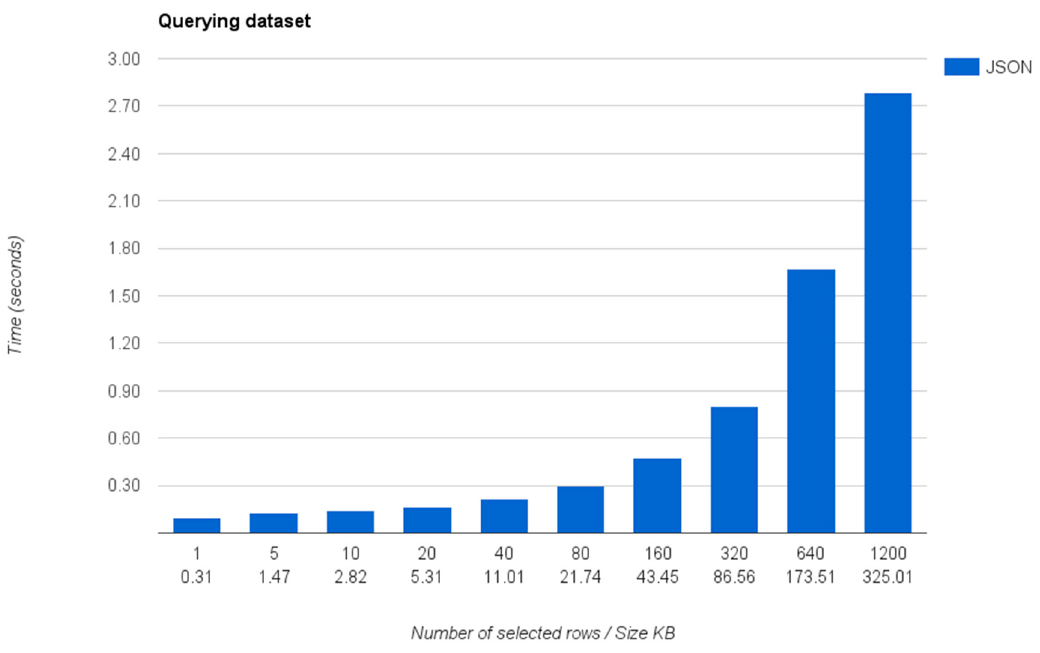
Figure 14. Query processing times in seconds depending on the number of rows retrieved from the dataset. As shown, the retrieval times are under 1 second when retrieving less than 320 rows (~87 KB) of data. The slowest retrieval occurs when the query causes the server to retrieve and transform all the data rows contained in the database (~1200 rows in the case of the example).